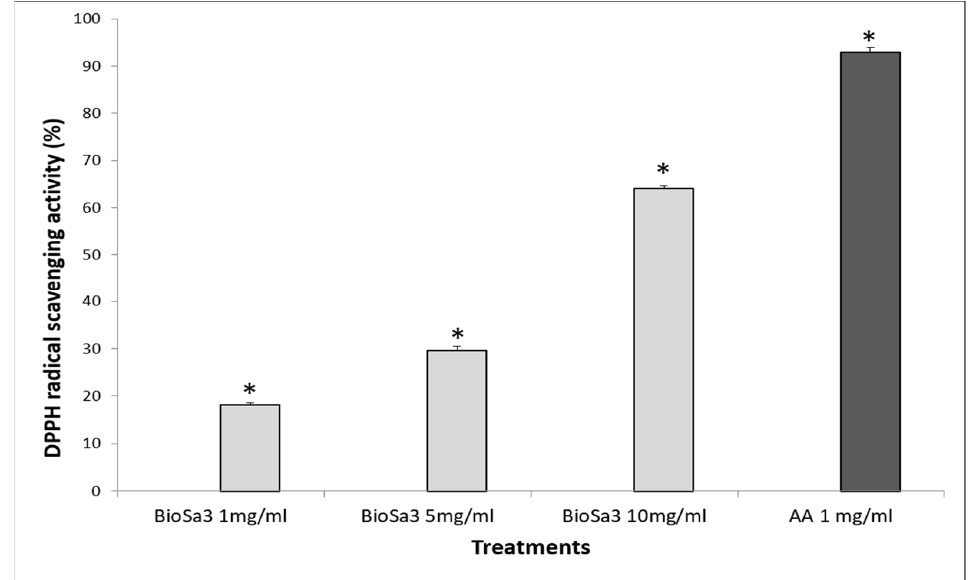
Figure 3. Antioxidant activity of the tested BioSa3. AA— ascorbic acid. *( p < 0.05).